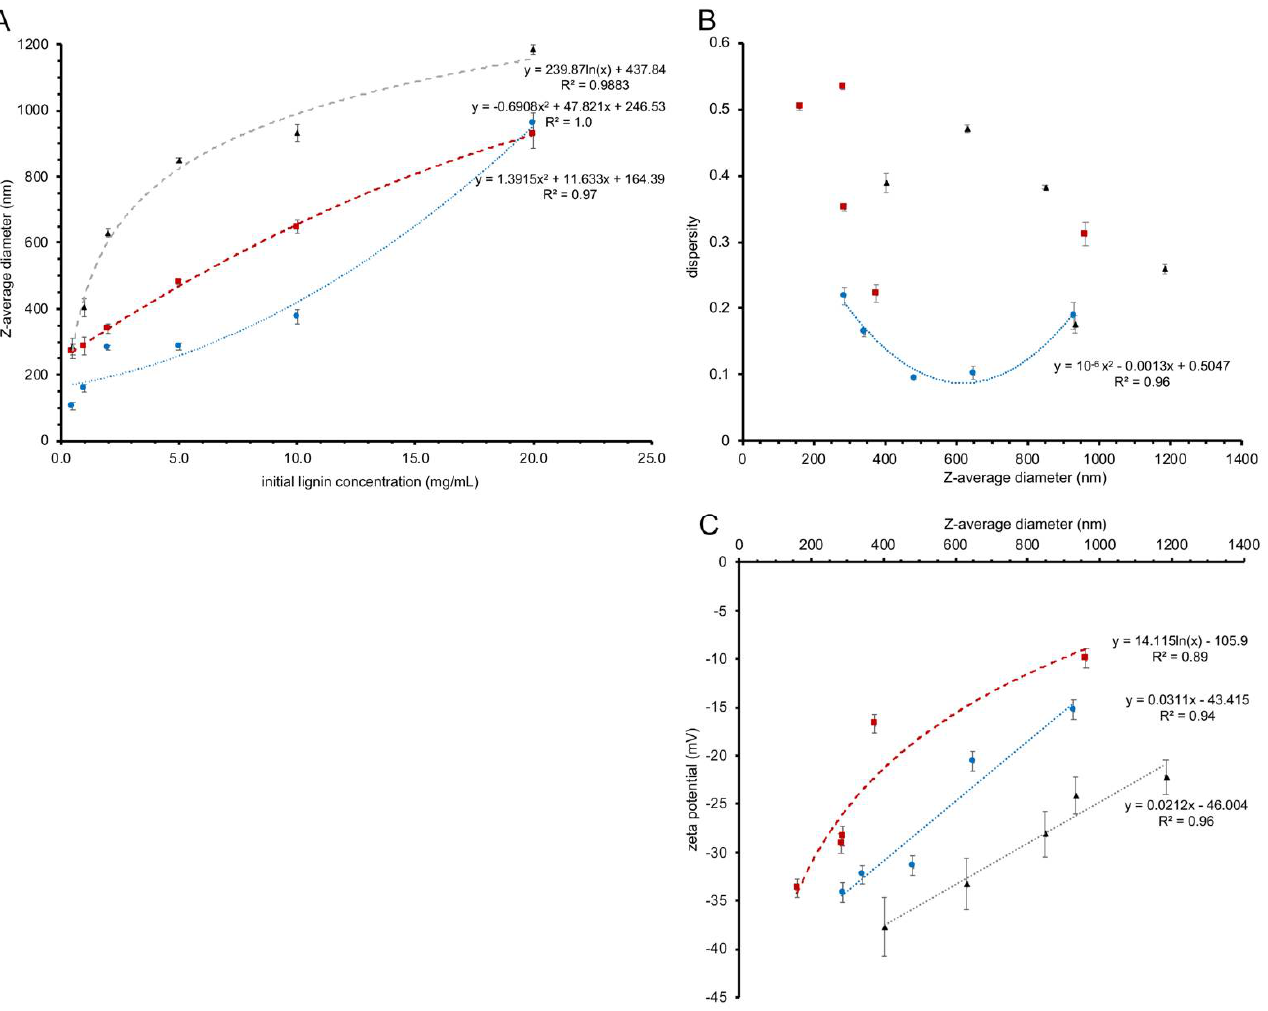
Figure 2. ( A ) Z-average size of nanoparticles made from birch BioLignin™ (red squares), wheat BioLignin™ (blue circles) and poplar TGA lignin (black triangles) as a function of the concentration of lignin at the start of the solvent exchange. The trend lines represent the best-fit polynomial (birch and wheat LNPs) or logarithmic function (poplar LNPs) for which the function and R 2 value are displayed. ( B ) Dispersity of nanoparticles made from birch BioLignin™ (red squares), wheat BioLignin™ (blue circles) and poplar TGA lignin (black triangles) as a function of their diameter, determined via dynamic light scattering. The trend line represents the best-fit polynomial, which could only be obtained for the wheat LNPs. ( C ) Zeta potential of nanoparticles formed from birch BioLignin™ (red squares), wheat BioLignin™ (blue circles) and poplar TGA lignin (black triangles) as a function of their diameter, determined via electrophoretic light scattering. The trend lines represent the best-fit polynomial (birch and poplar LNPs) or logarithmic function (wheat LNPs) for which the function and R 2 value are displayed. In all three graphs the error bars represent the standard deviation based on three